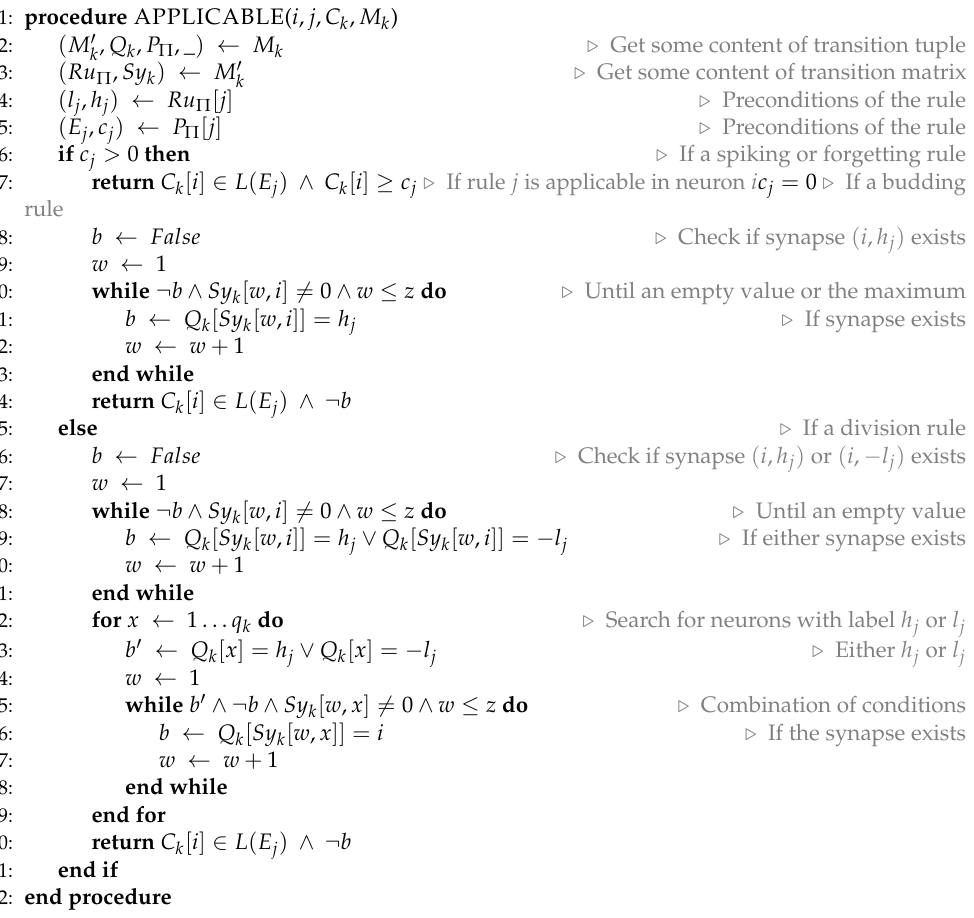
Algorithm 8 Applicable functions for dynamic SNP systems with budding rules over optimized compressed matrix